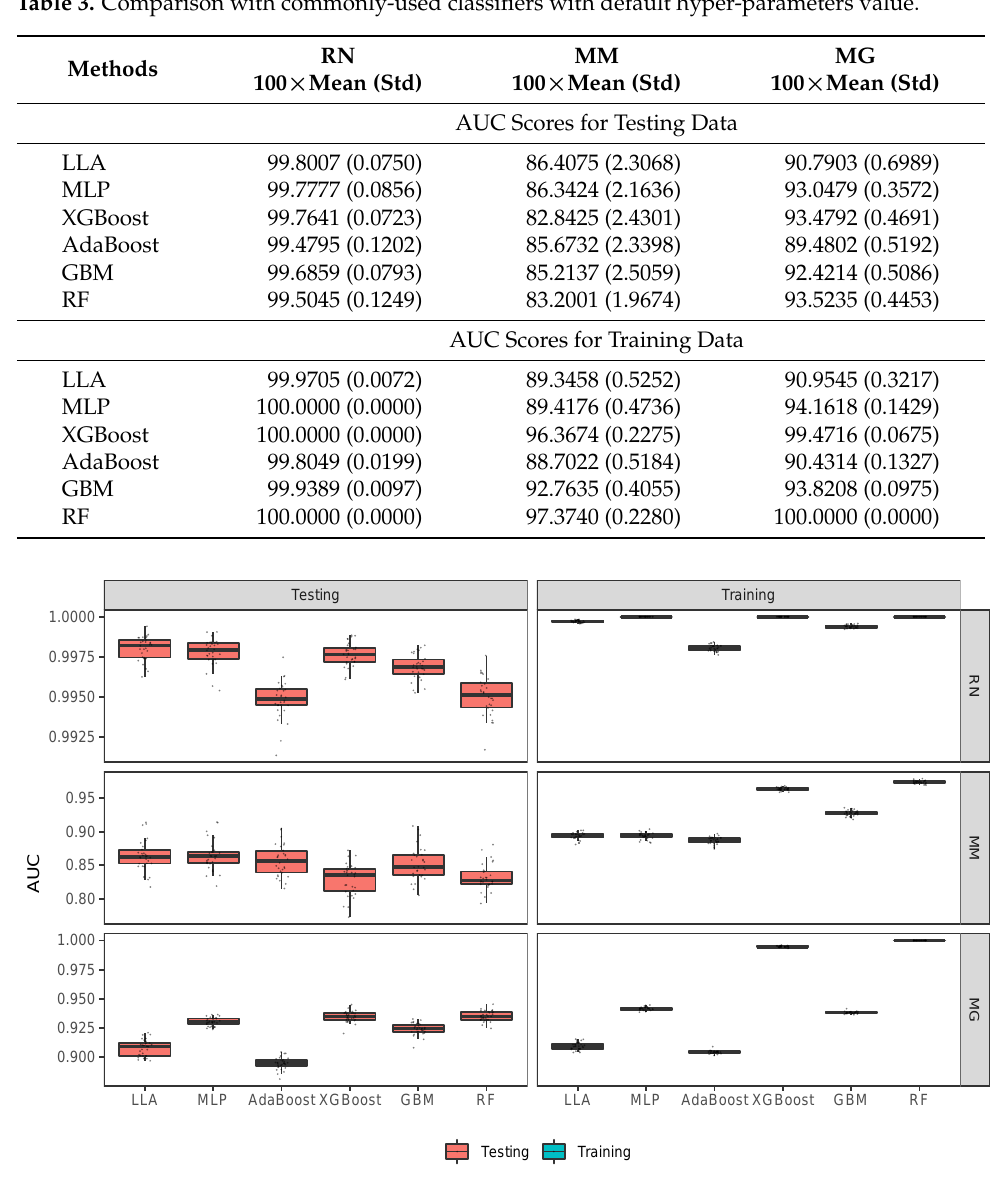
Figure 7. Box plots of 30 AUCs for the LLA and the five commonly-used procedures with default hyper-parameter values for classification